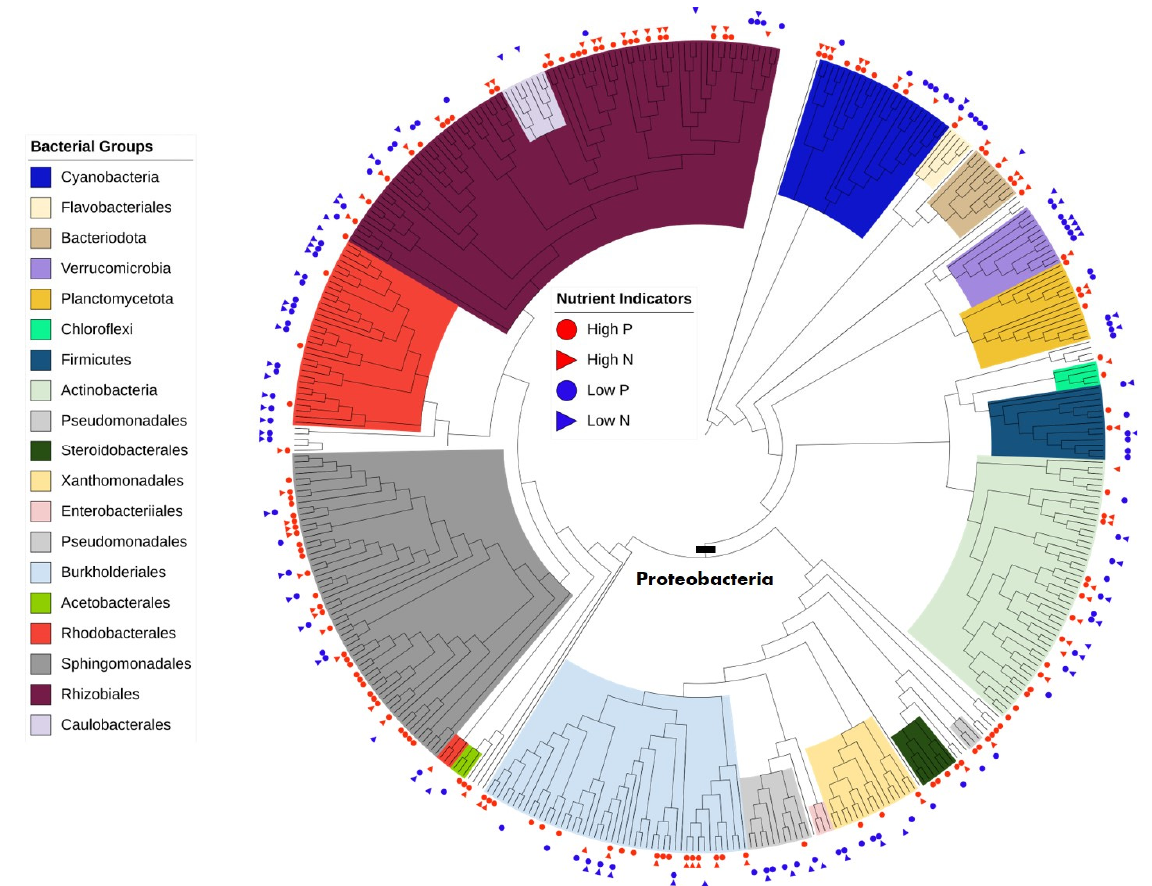
Figure 7. Phylogenetic tree of the 429 ASVs comprising 75% of the total relative abundance among all samples. Indicator ASVs from TITAN are marked. Major bacterial taxonomic groups are color coded in the legend in the order they appear in the tree, clockwise from the cyanobacteria near the top. Groups with only 1 or 2 members are unmarked. The majority of ASVs (N=285) were members of the phylum Proteobacteria (Figure 7, Table 5). Other phyla in the top 75% with more than 10 ASVs included Actinobacteria (48 ASVs), Cyanobacteria (26 ASVs), Bacteroidota (16 ASVs), Firmicutes (14 ASVs), Planc- tomycetota (14 ASVs), and Verrucomicrobiota (11 ASVs) (Figures 7 and 8). Bacterial phyla